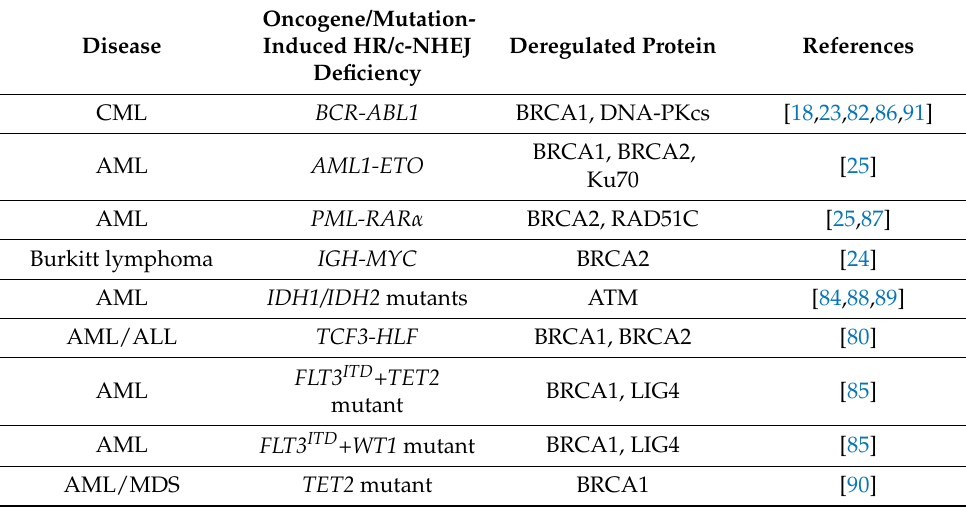
Figure 2. Scheme of PARP inhibitors administered in hematopoietic malignancies and other tu- mors displaying HR/c-NHEJ deficiency induced by oncogenes/mutations ( A ) and tyrosine kinase inhibitors ( B ). Table 1. Oncogenes/Mutations inducing HR/c-NHEJ